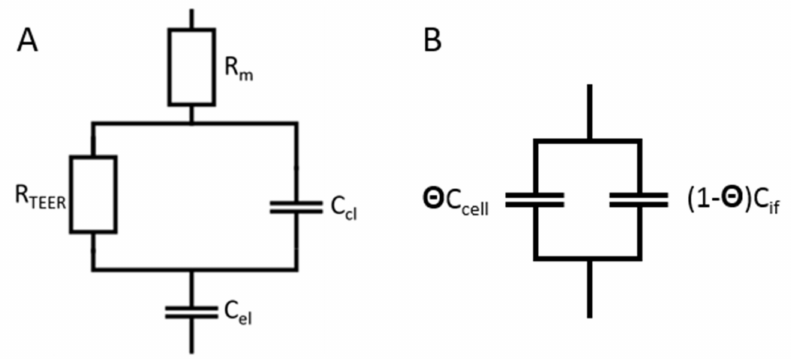
Figure A2. ( A ) Equivalent circuit diagrams employed for impedance spectroscopy data evaluation. ( B ) C cl composed of a parallel connection of the capacitance, C cell , of the cell layer on covered areas and the capacitance of the gel/medium interface, C if , on areas bare of